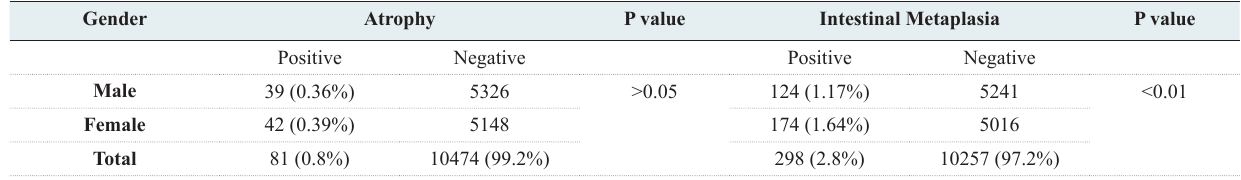
Table 1: Distribution of atrophy and intestinal metaplasia according to the gender